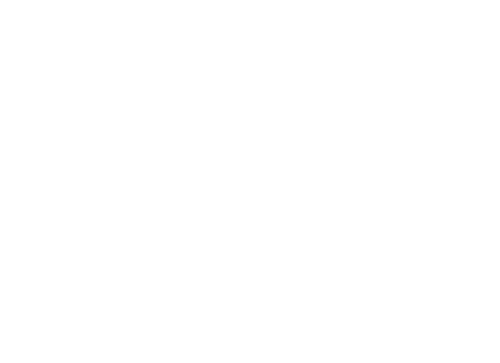
Figure 6. Spiral updating position (red circle denotes the position of prey while yellow circle is the position of a whale).